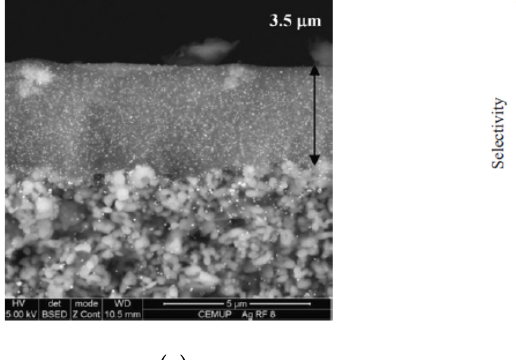
Table 1. Gas permeabilities of c‐CMSM at 293 K in function of C/Al ratio [50]. Membrane c/alumina (wt.%)